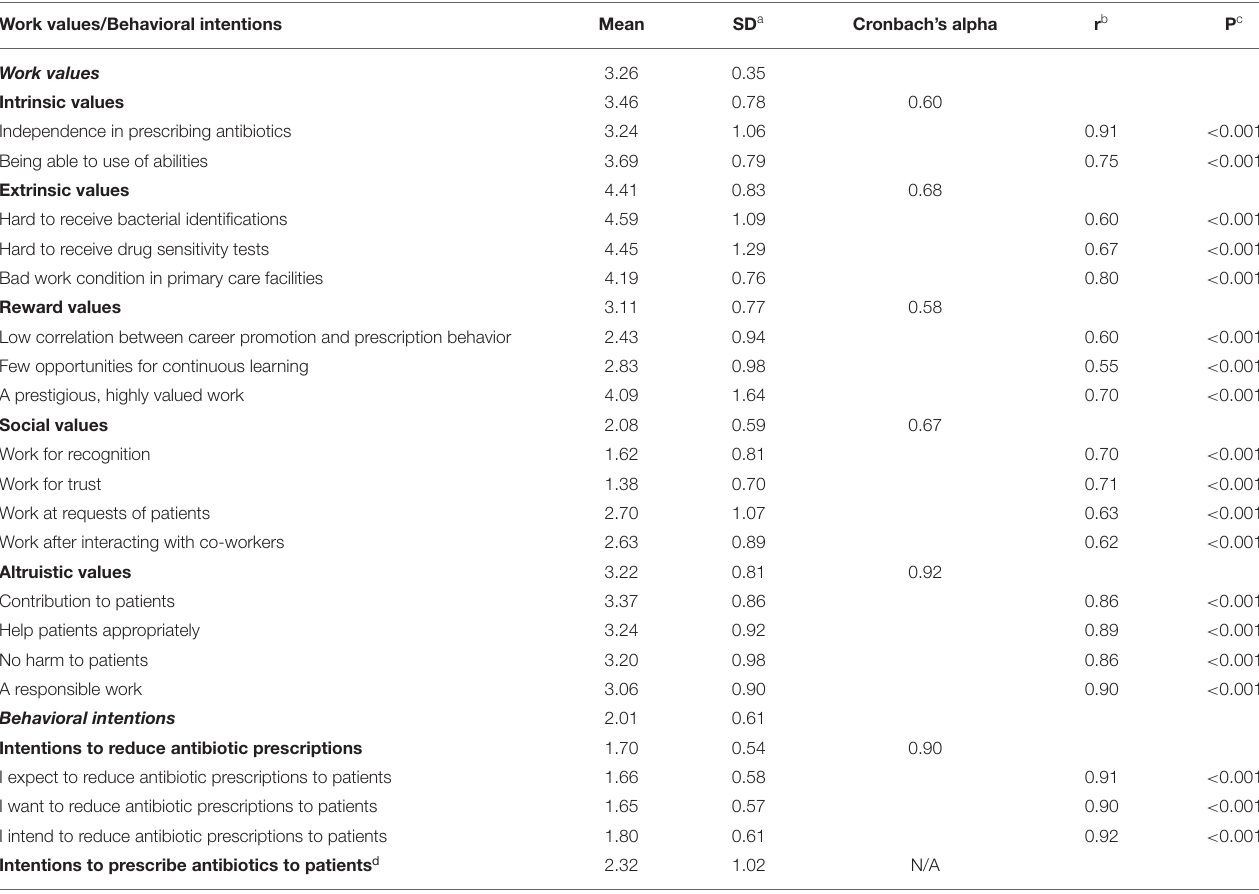
TABLE 2 | Work values regarding antibiotic use and behavioral